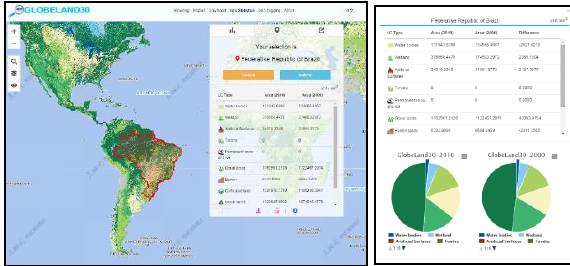
Figure 8 Demonstration of the user requests in GlobeLand30 GSA. (a) The user request and corresponding the land cover analysis result; (b) the analysis result of the land cover change between 2000 and